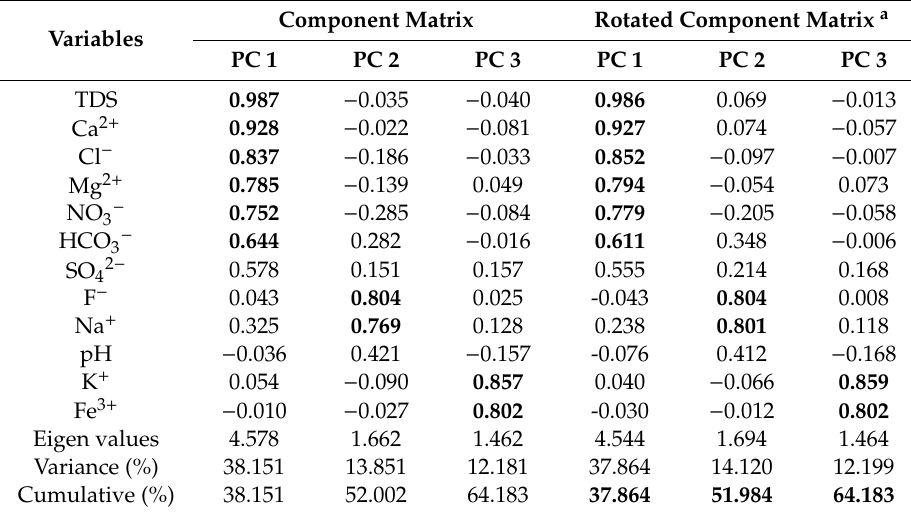
Table 3. Component and varimax rotated component